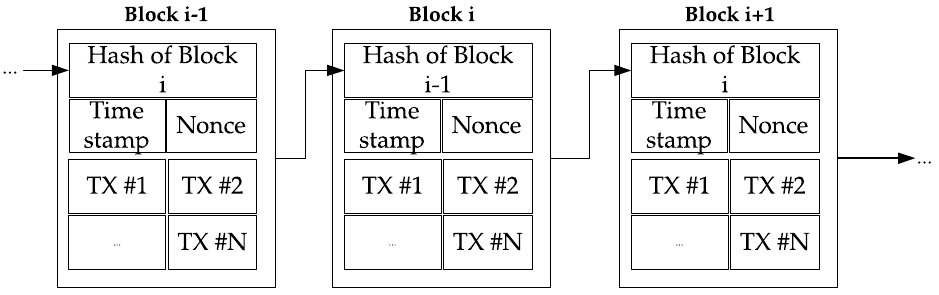
Figure 3. An example of chain configuration using blocks.